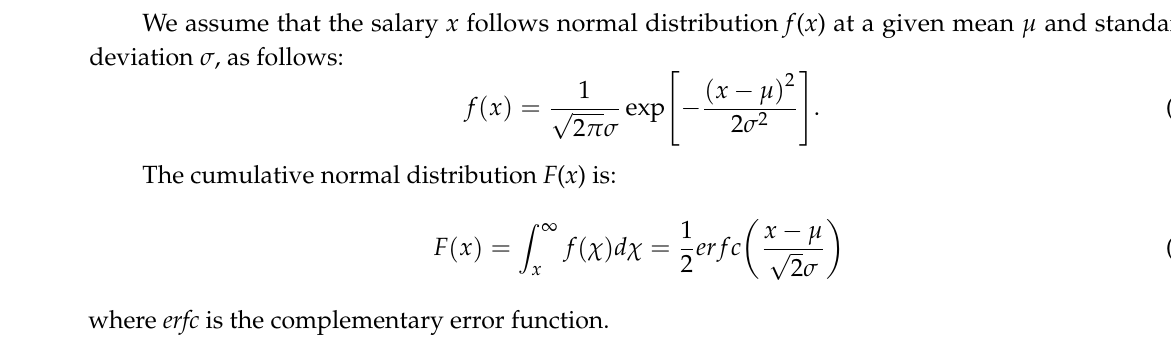
Figure 1. Salary distribution in the cities of Rochester, Buffalo, and New York City (NYC).